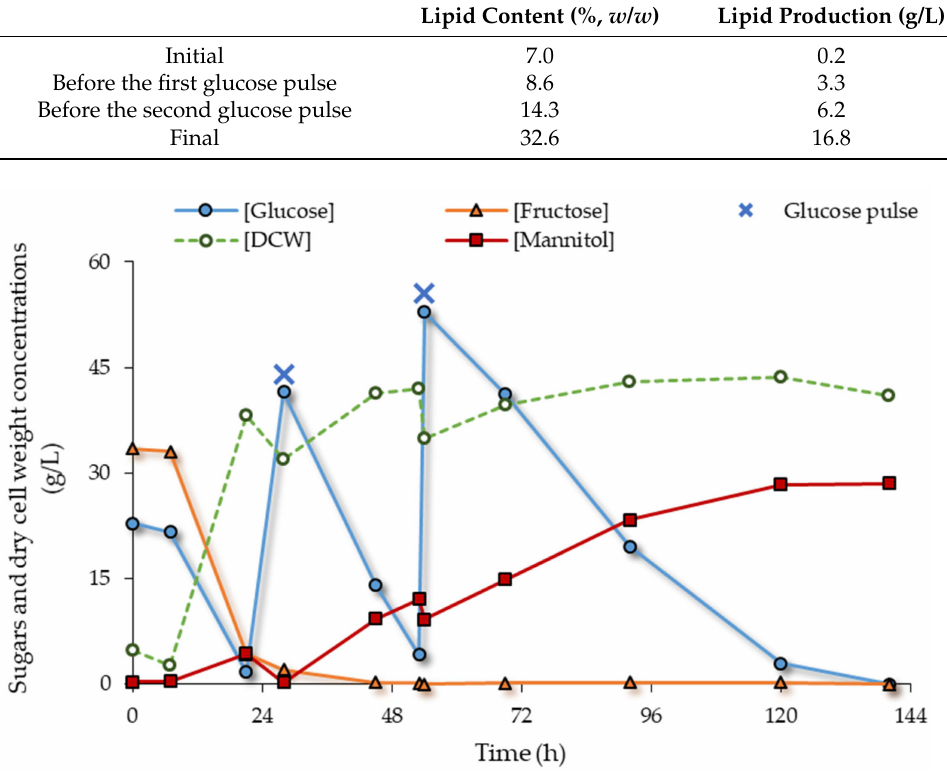
Figure 2. Time course of sugars and cell biomass during the fed-batch culture by C. curvatus on DPW-LF through glucose